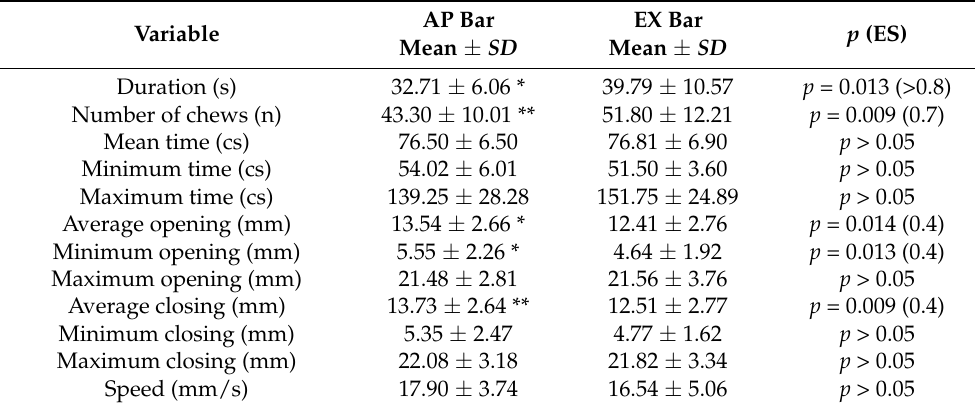
Table 3. Comparison of oral processing of the Aptonia (AP) and Etixx (EX) bars. The data are expressed as mean values with their standard deviations ( SD s), significances ( p ), and Cohen effect sizes